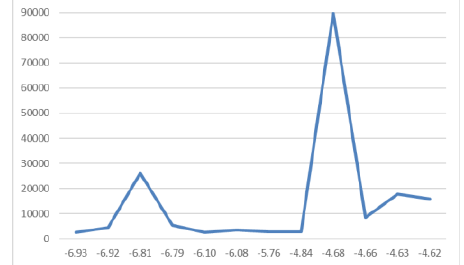
Figure 6. Number of points for each extracted plane.